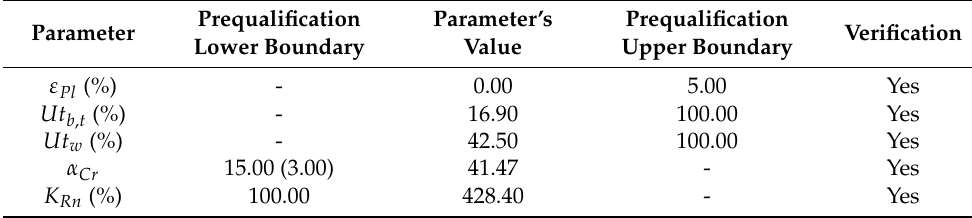
Table 6. Essential results of the 8ES EPC ST model.